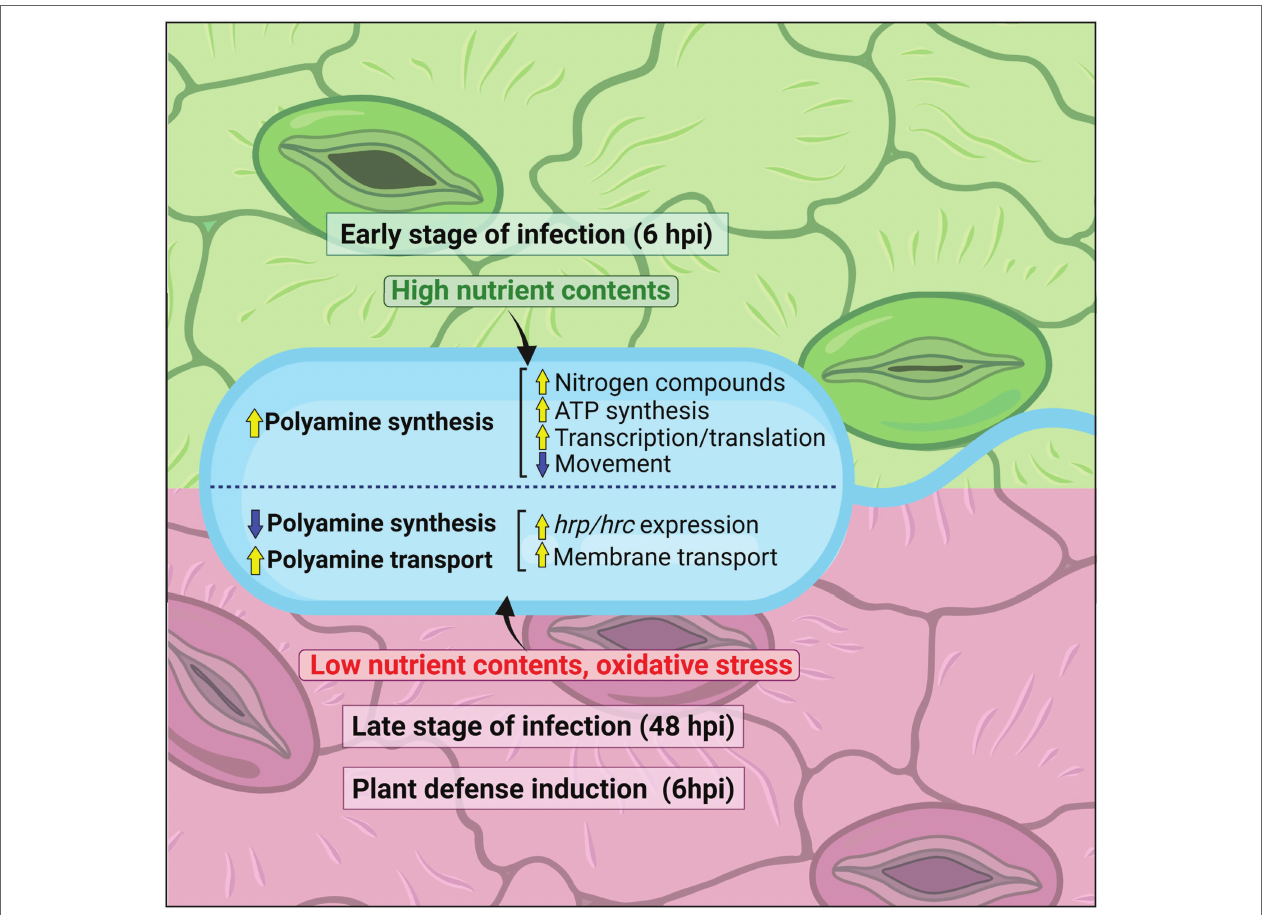
FIGURE 6 | Scheme showing how the polyamine metabolism in P. syringae changes during plant invasion at different phases of infection. For the early stages of infection (6 hpi), polyamine metabolism regulatory hallmarks and their correlation with metabolic responses are mentioned on top of the figure, whereas for the late stages of infection (48 hpi) or the initial periods after induction of plant defensive responses are displayed